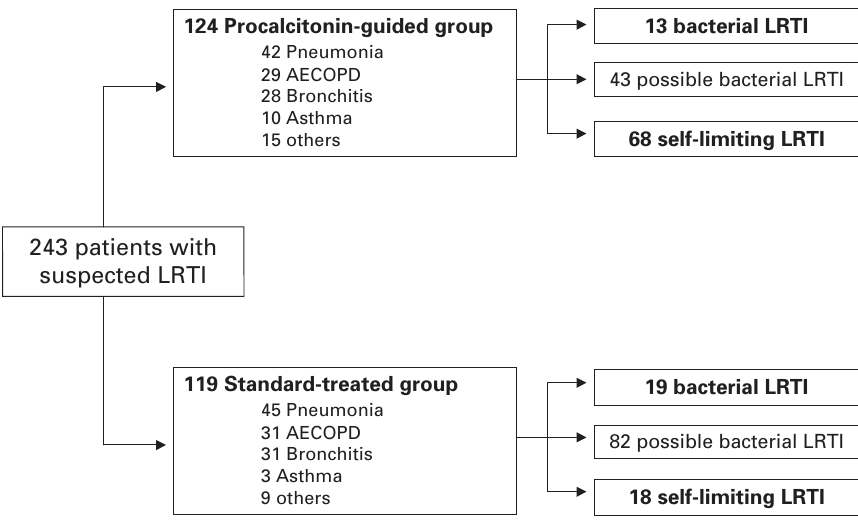
Figure 1 Trial profile. AB denotes antibiotics, AECOPD acute exac- erbation of